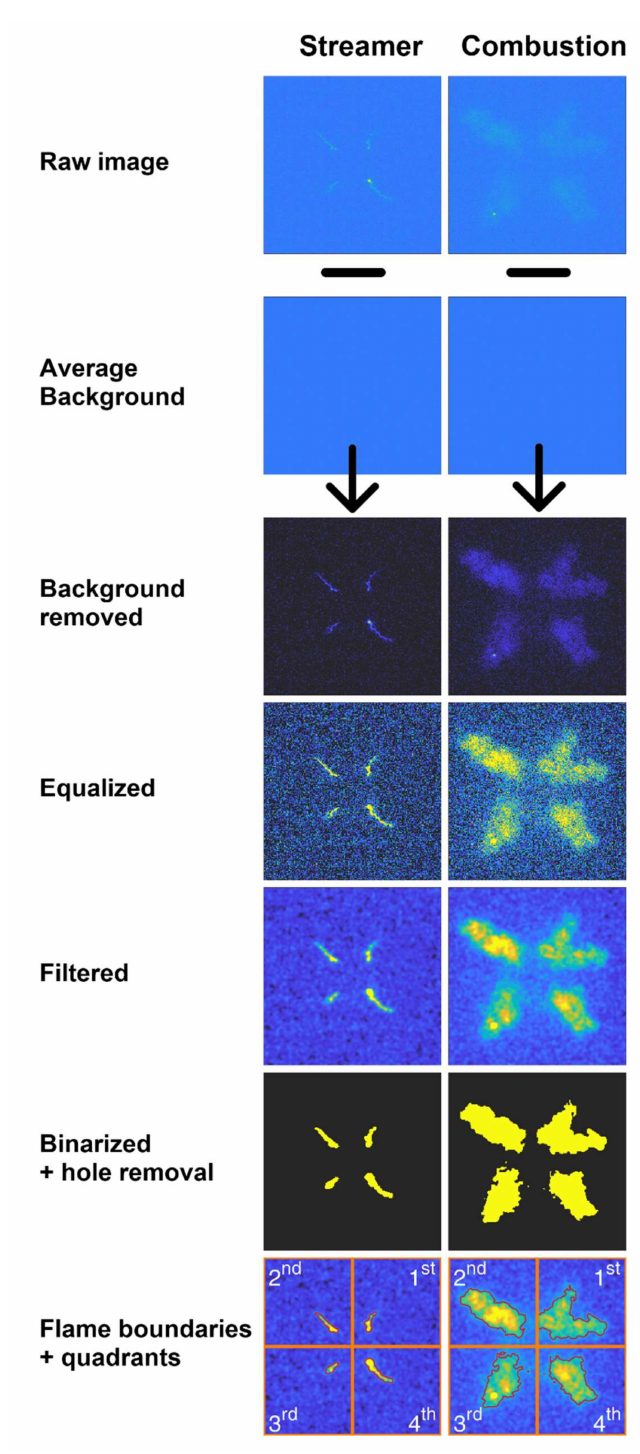
Figure 5. Preliminary preprocessing procedure, common for “pure streamer” frames (left column) and combustion frames (right